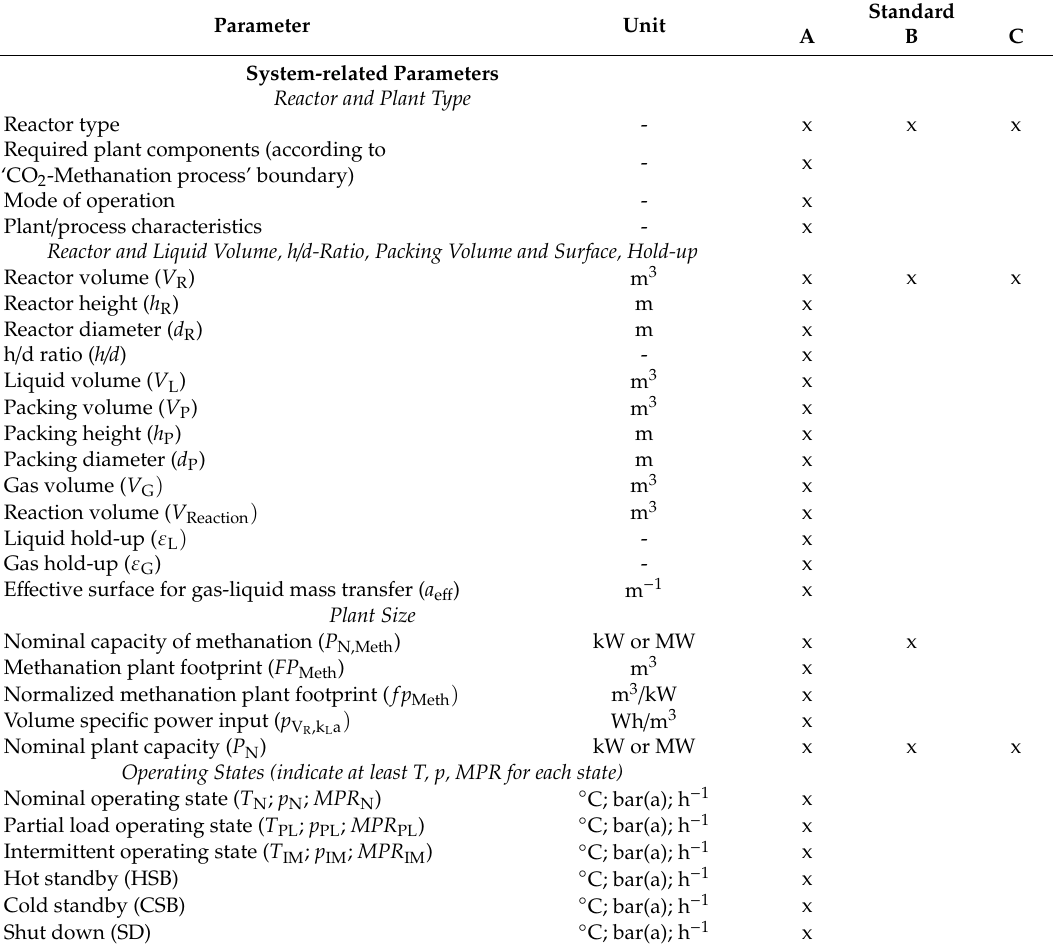
Table A2. Parameter matrix blueprint and standard classification. ‘A-Standard’: detailed scientific information, ‘B-Standard’: basic and economic information, ‘C-Standard’: basic information provided. x parameter has to be provided in the respective standard; - parameter not needed to fulfill the respective